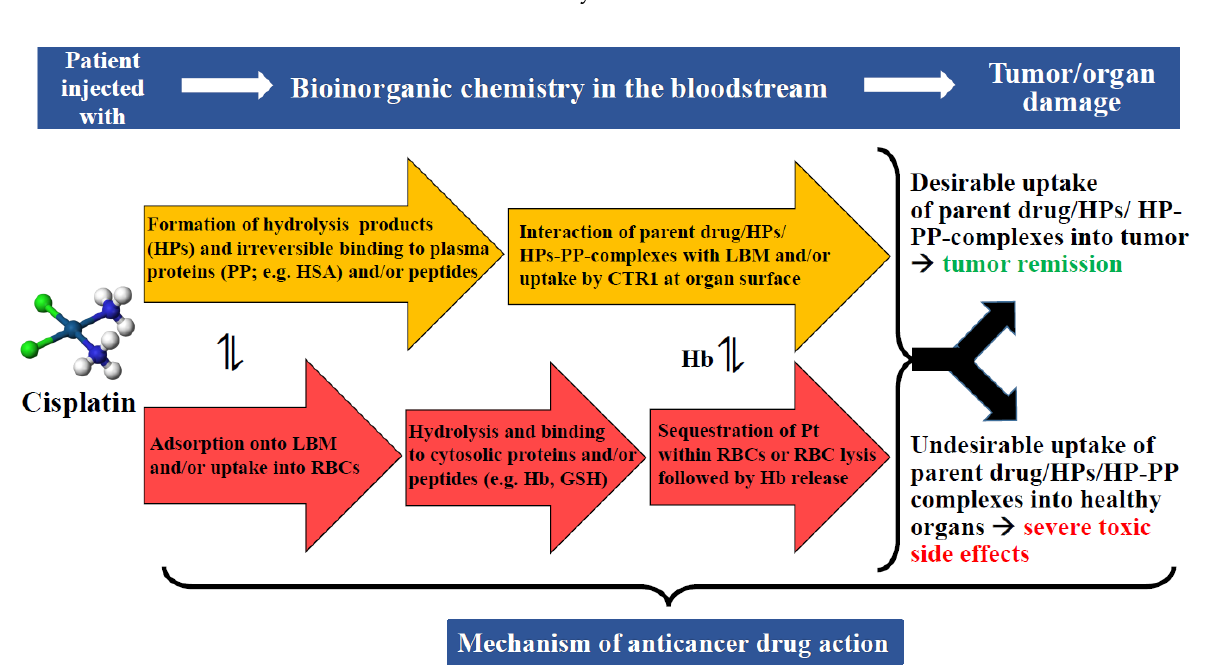
Figure 4. Bioinorganic chemistry of cytotoxic anticancer metallodrugs that unfold in plasma (yellow) and red blood cells (red) are critical to establish their mechanism of action, as they determine the degree of tumor damage/tumor shrinkage over days/weeks. Abbreviations: human serum albumin (HSA), red blood cells (RBC), hemoglobin (Hb), glutathione (GSH), lipid bilayer membrane (LBM), copper transporter 1 (CTR1).